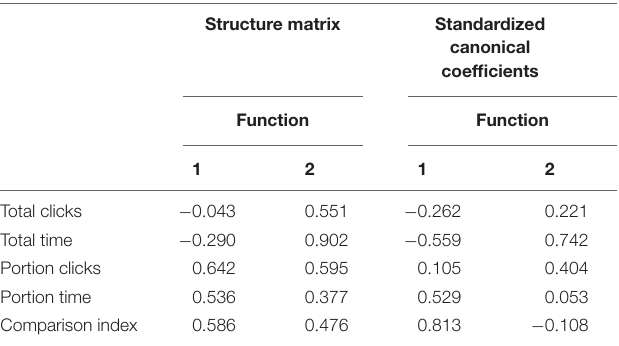
TABLE 4 | Structure Matrix and Standardized Canonical